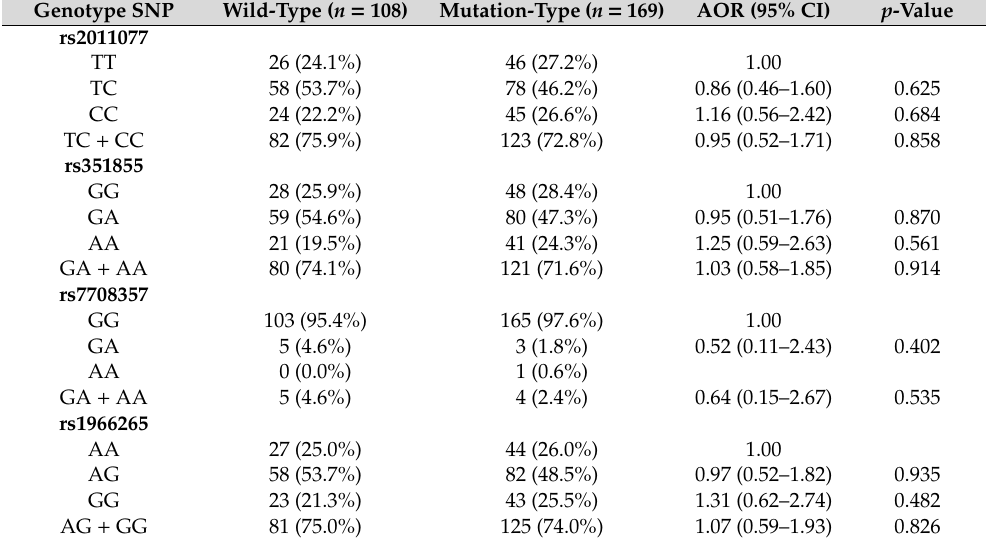
Table 2. Distribution frequency of fibroblast growth factor receptor 4 ( FGFR4 ) genotypes of patients with lung adenocarcinoma and multiple logistic regression analysis of EGFR mutation association.